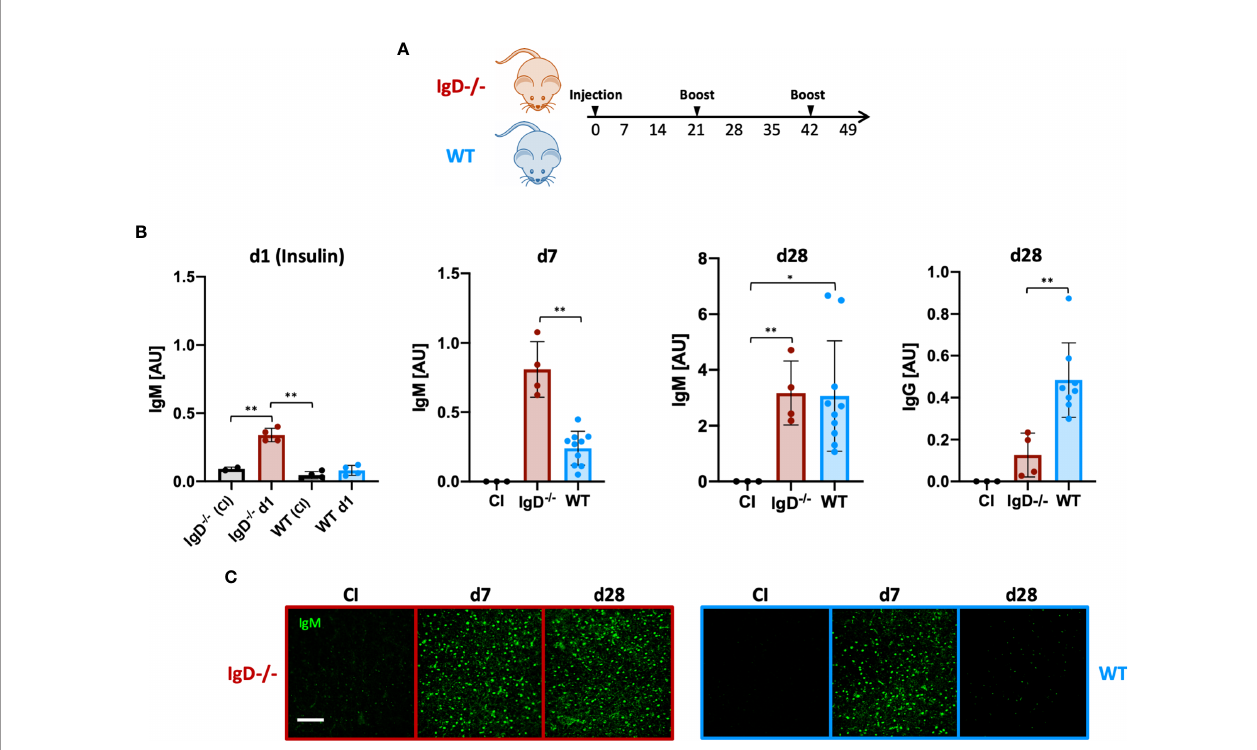
FIGURE 3 | The IgD-class BCR is required to prevent rapid immune response to autoantigens and induces af fi nity maturation. (A) Schematic immunization schedule of IgD-de fi cient and WT mice injected with InsA-KLH + CpG ODN1826 on day 0 and InsA-KLH on days 21 and 42. (B) Serum immunoglobulin titers reactive to native insulin of IgD-de fi cient (n=4) and WT (n=10) mice immunized with InsA-KLH or CI (n=3) measured by ELISA. Days are indicated in the fi gure. Mean, ± SD. Students t-tests with Welch ’ s correction were used to compare two groups within one experiment. (C) Serum immunoglobulins reactive to self-molecules (DNA/ RNA) of InsA-KLH and CI injected IgD-de fi cient (n=5/day) and WT (n=5/day) mice tested via HEp2 slides. Fluorescence microscopy images are representative of three independent experiments. Scale bar: 10 µm *P < 0.05, **P <